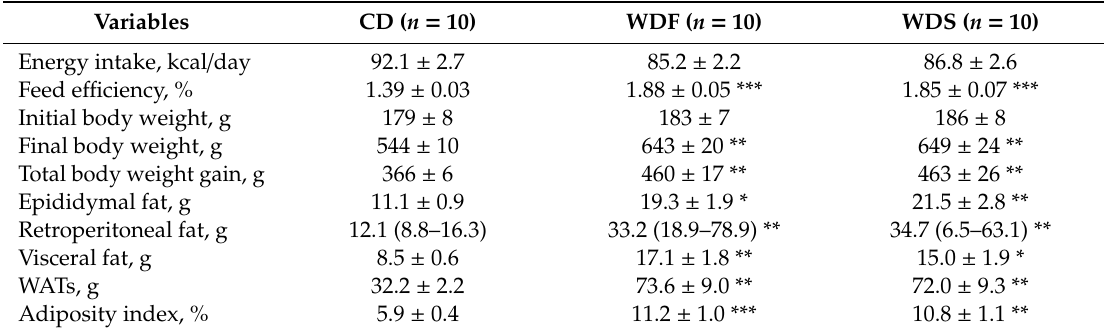
Table 2. Nutritional profile of the animals.